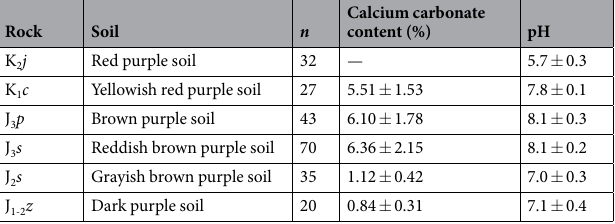
Table 7. Calcium carbonate contents and pH values of the purple soils.